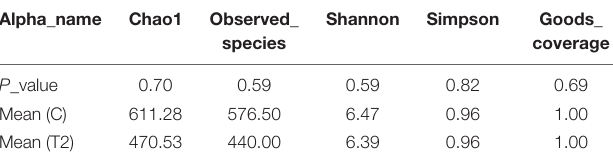
TABLE 2 | Alpha diversity indices of two groups.